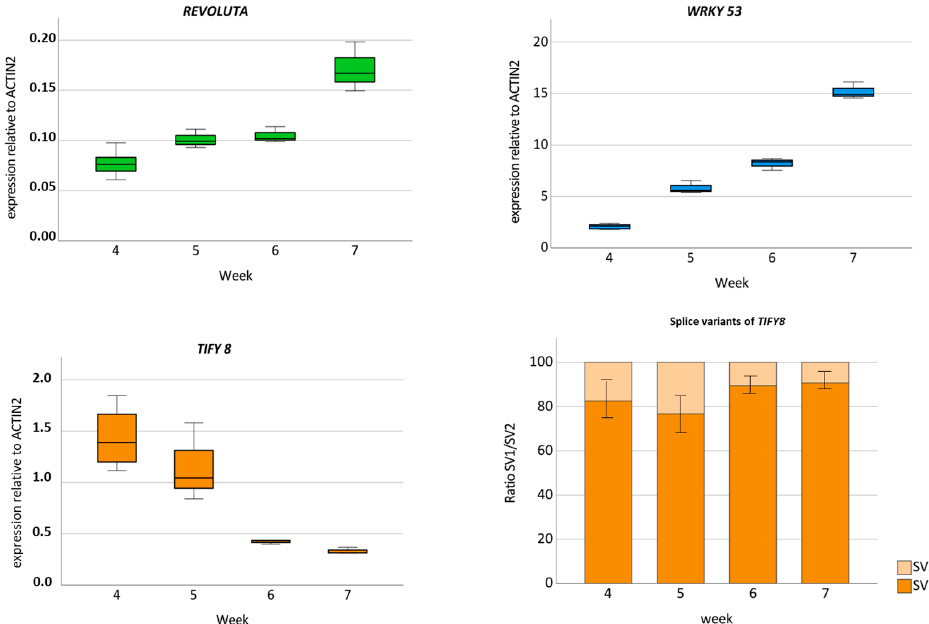
Figure 4. Boxplots presenting the expression of REVOLUTA , WRKY53, and TIFY8 over time in leaf tissue of Arabidopsis wildtype plants Col-0. Leaves No. 6 and 7 of each rosette were harvested from 4- to 7-week-old plants. Expression levels were determined via qRT-PCR, and values were normalized to ACTIN2 ( n = 3). In the case of TIFY8 , the ratio for the two existing splicing variants (SV1, SV2, see Figure S2) was determined.